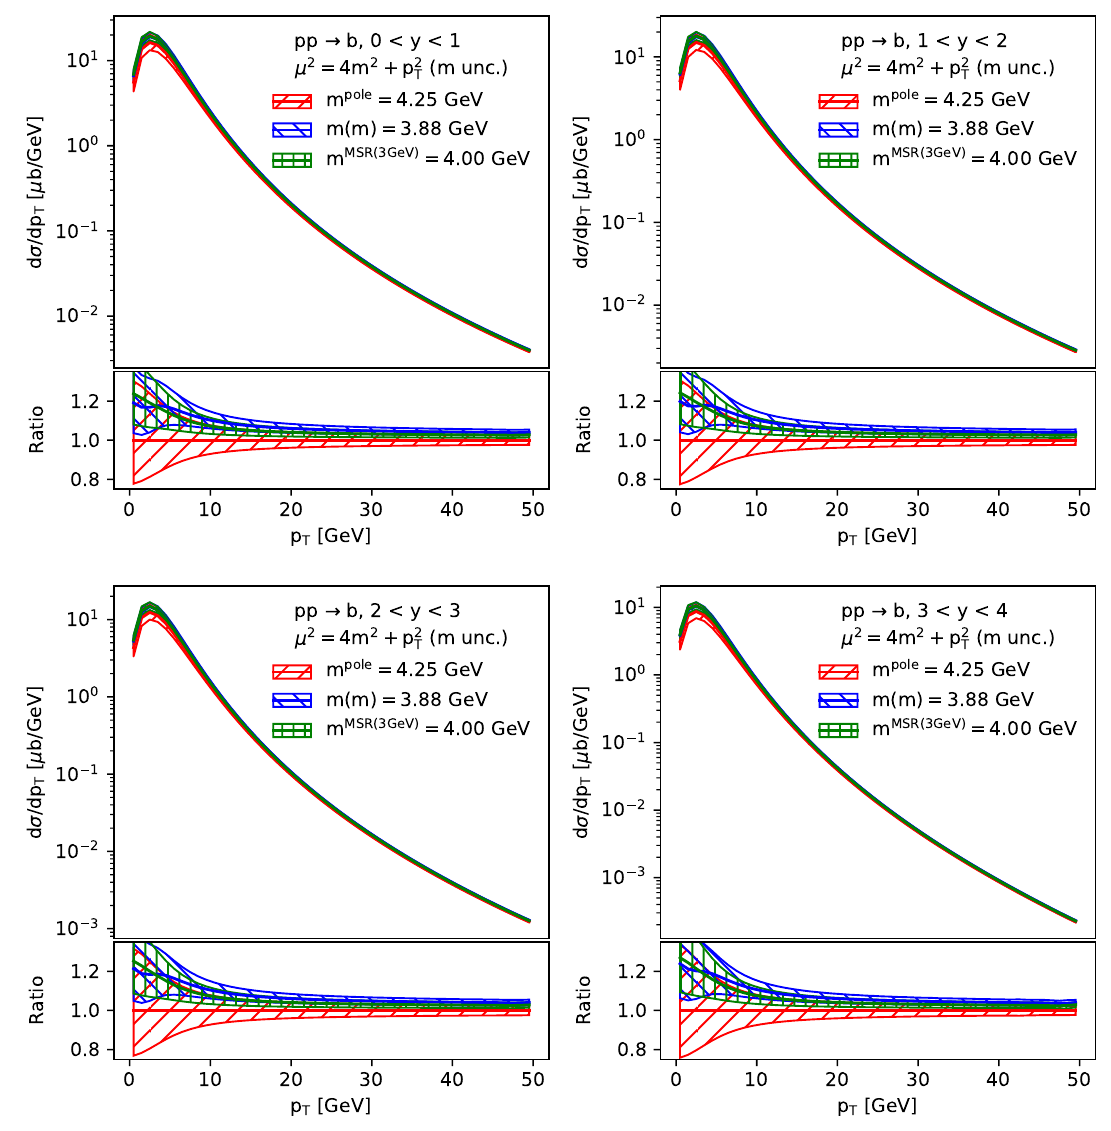
Figure 11 . Same as figure 10, but for the bottom-mass value m b ( m b ) = 3.88 ± 0.13 GeV (converted to m MSR (3 GeV) = 4.00 ± 0.13 GeV and m MSR = 4.25 ± 0.25 GeV), as extracted in the ABMP16 b b NLO fit. The size of the uncertainties of the predictions with the heavy-quark mass renormalized in the MS and MSR schemes are larger than in figure 10 because the uncertainties of the ABMP MS fitted masses are larger than the uncertainties of the MS masses reported by the PDG